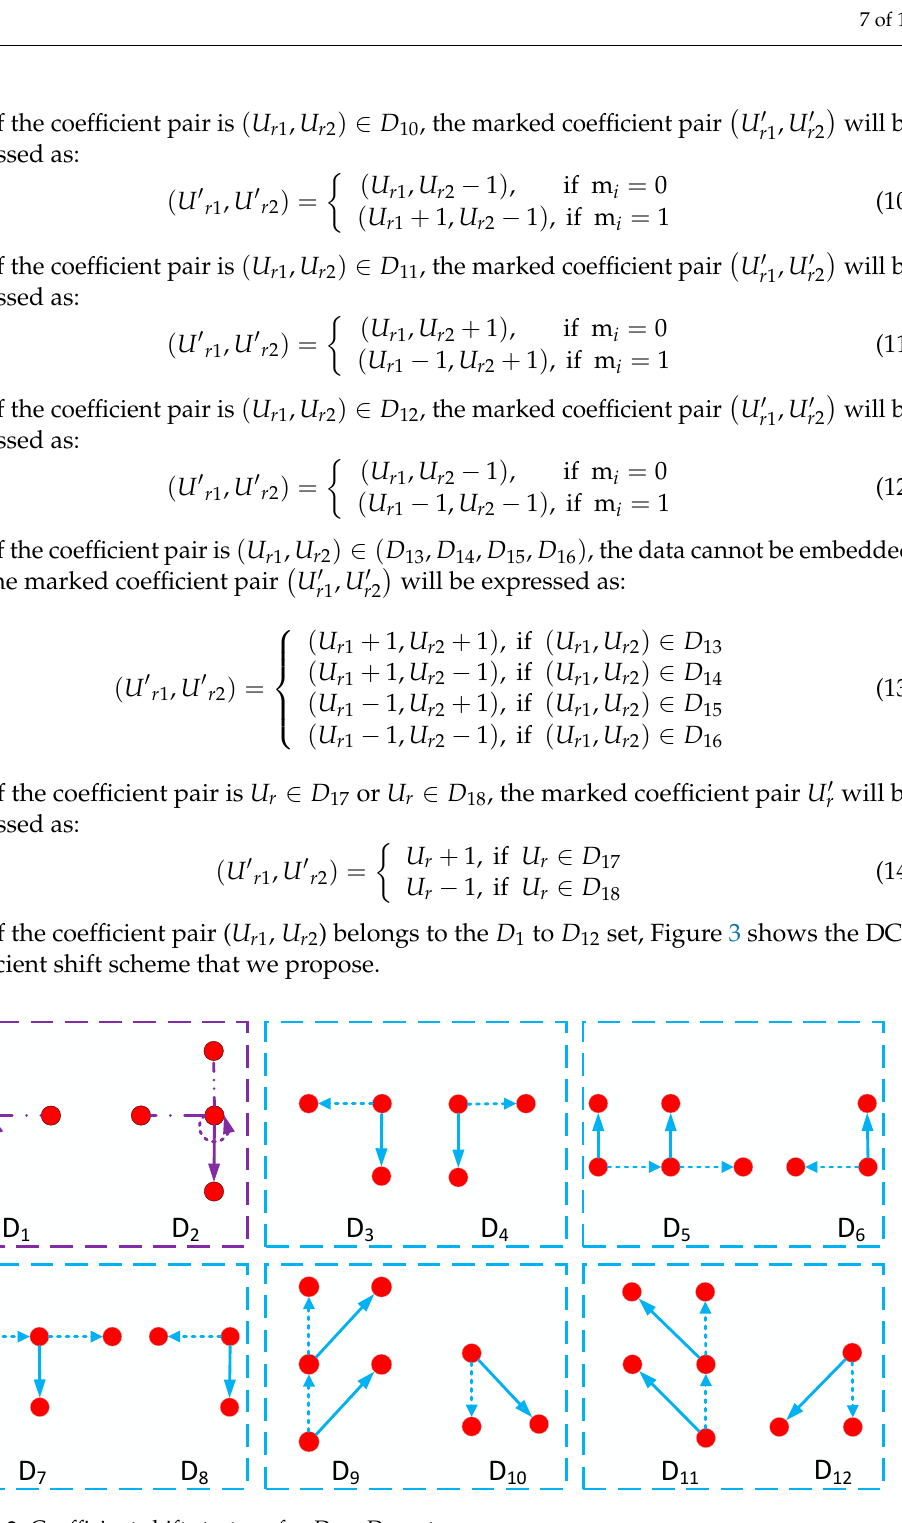
𝐸𝐶 (cid:3043)(cid:3045)(cid:3032) is the embedding capacity of this scheme. Based on the traditional two-